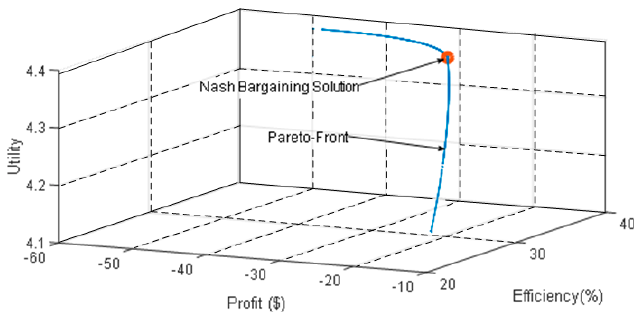
Figure 18. Pareto-front and NBS of the MO power management of an islanded MG.